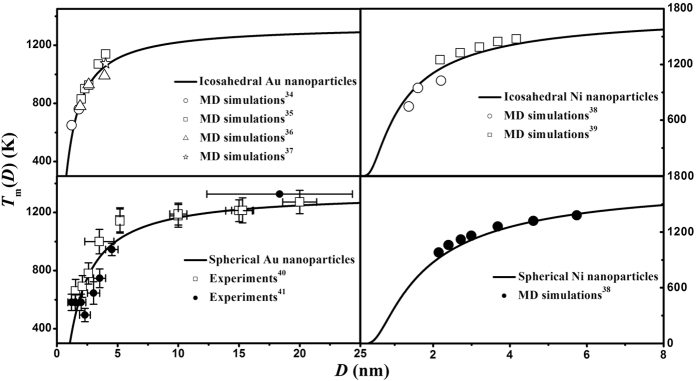
Comparisons of Tm(D,λ) functions for spherical and icosahedral Au and Ni nanoparticles between the predictions in terms of Eq. (3) and the corresponding MD simulation results343536373839 or experimental data4041.